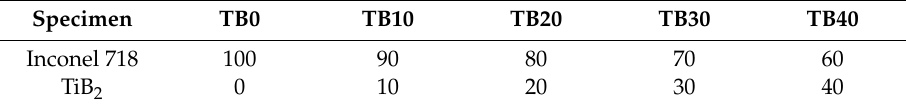
Table 2. Composition ratio of mixed powder